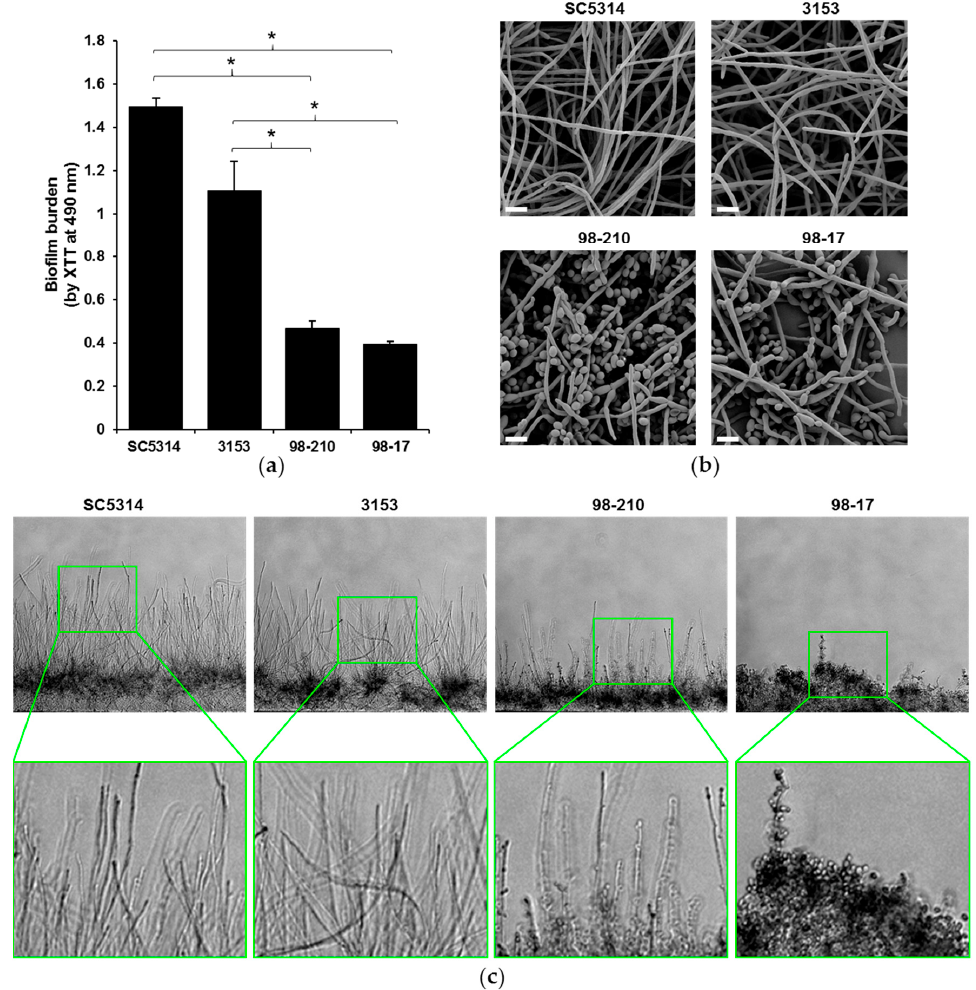
Figure 2. C. albicans clinical isolates have differing biofilm architectures. ( a ) The biofilm-forming capacity of isolates was estimated by an XTT metabolic assay after 24 h of biofilm growth. Statistical significance was analyzed by ANOVA with pairwise comparison by the Holm–Sidak method, * p < 0.05, n = 3, representative data with SD shown; ( b ) Biofilms were imaged by scanning electron microscopy to visualize the surface architecture. Measurement bars represent 10 µ m for 2000 × images; ( c ) The depth of the biofilms was examined by cross-sectional analysis of C. albicans biofilms growing in microfluidic devices. Original images were taken at 10 ×